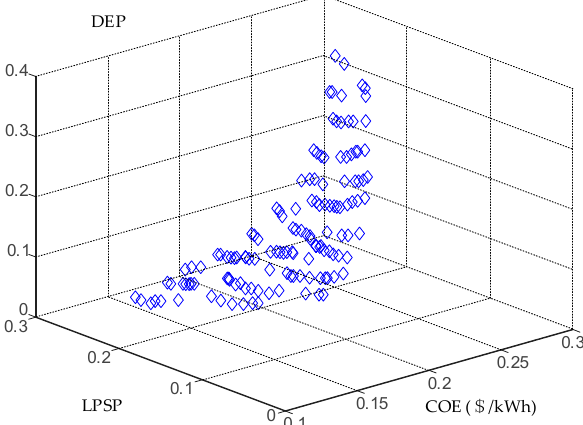
Figure 12. The Pareto front obtained by HSMGWO.